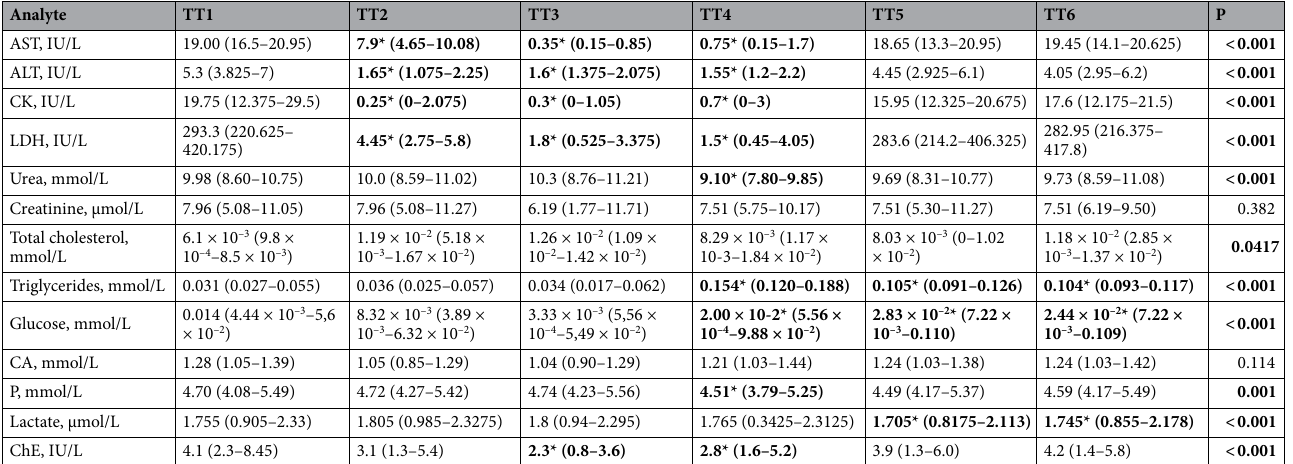
Table 3. Effect of inactivation protocols in salivary biomarkers of metabolic status, kidney function and tissue damage [median (25–75 percentile)]. Significant values are in bold. *P < 0.05. Control (TT1); 65 °C 30